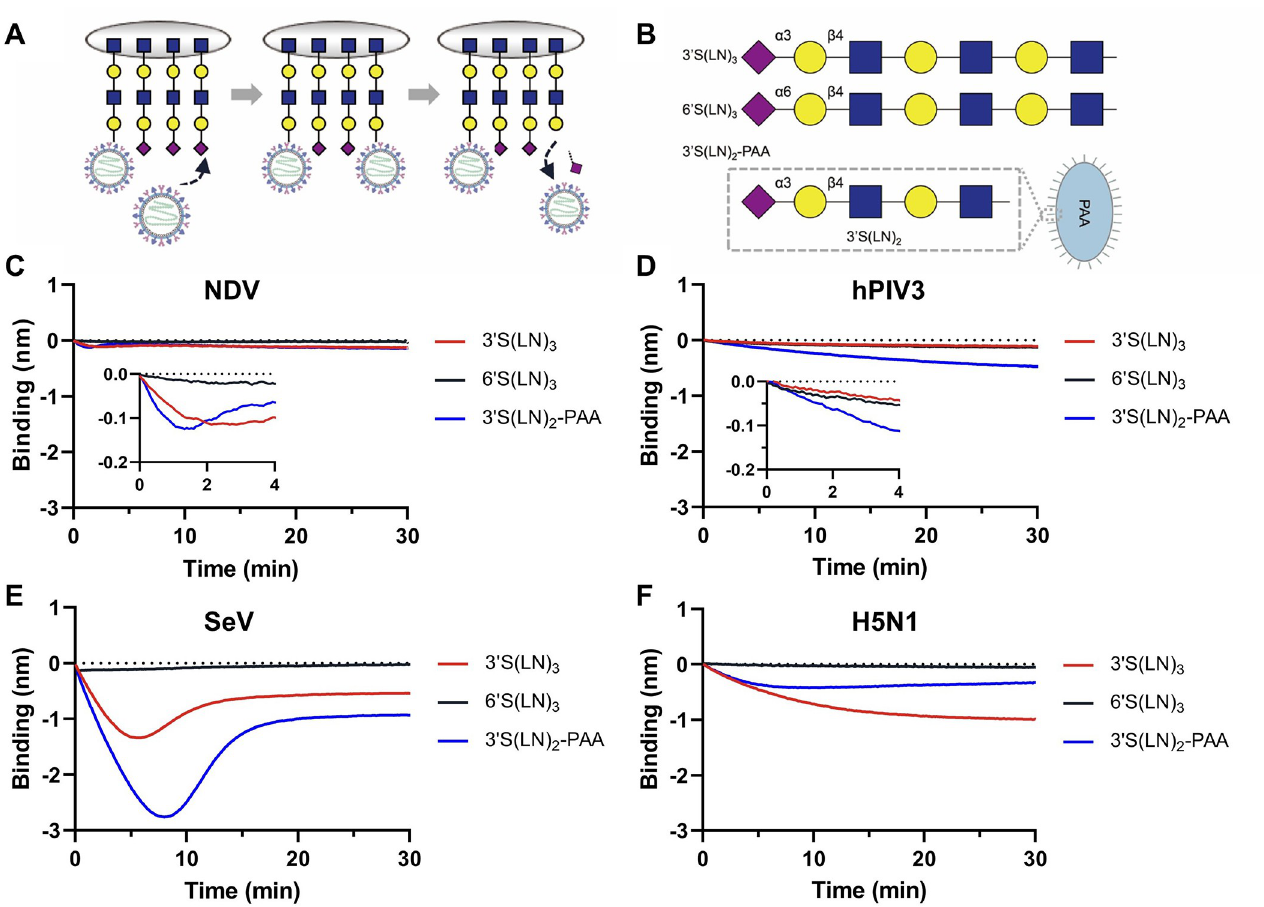
Fig 2. Binding of NDV, hPIV3 and SeV to different sialoglycans. (A) Schematic representation of the interaction between virus particles and synthetic biotinylated glycans. (B) Biotinylated sialoglycans used in this study are: 3’S(LN) 3 : Neu5Ac α 2-3Gal β 1-4GlcNAc β 1-3Gal β 1-4GlcNAc β 1-3Gal β 1-4GlcNAc, 6’S (LN) 3 : NeuAc α 2-6Gal β 1-4GlcNAc β 1-3Gal β 1-4GlcNAc β 1-3Gal β 1-4GlcNAc; and 3’S(LN) 2 -PAA: Neu5Ac α 2-3Gal β 1-4GlcNAc β 1-3Gal β 1-4GlcNAc on a polyacrylamide backbone. Binding curves were generated for NDV ( C ), hPIV3 ( D ), SeV ( E ) and H5N1 ( F ) at 10 10 particles/ml.